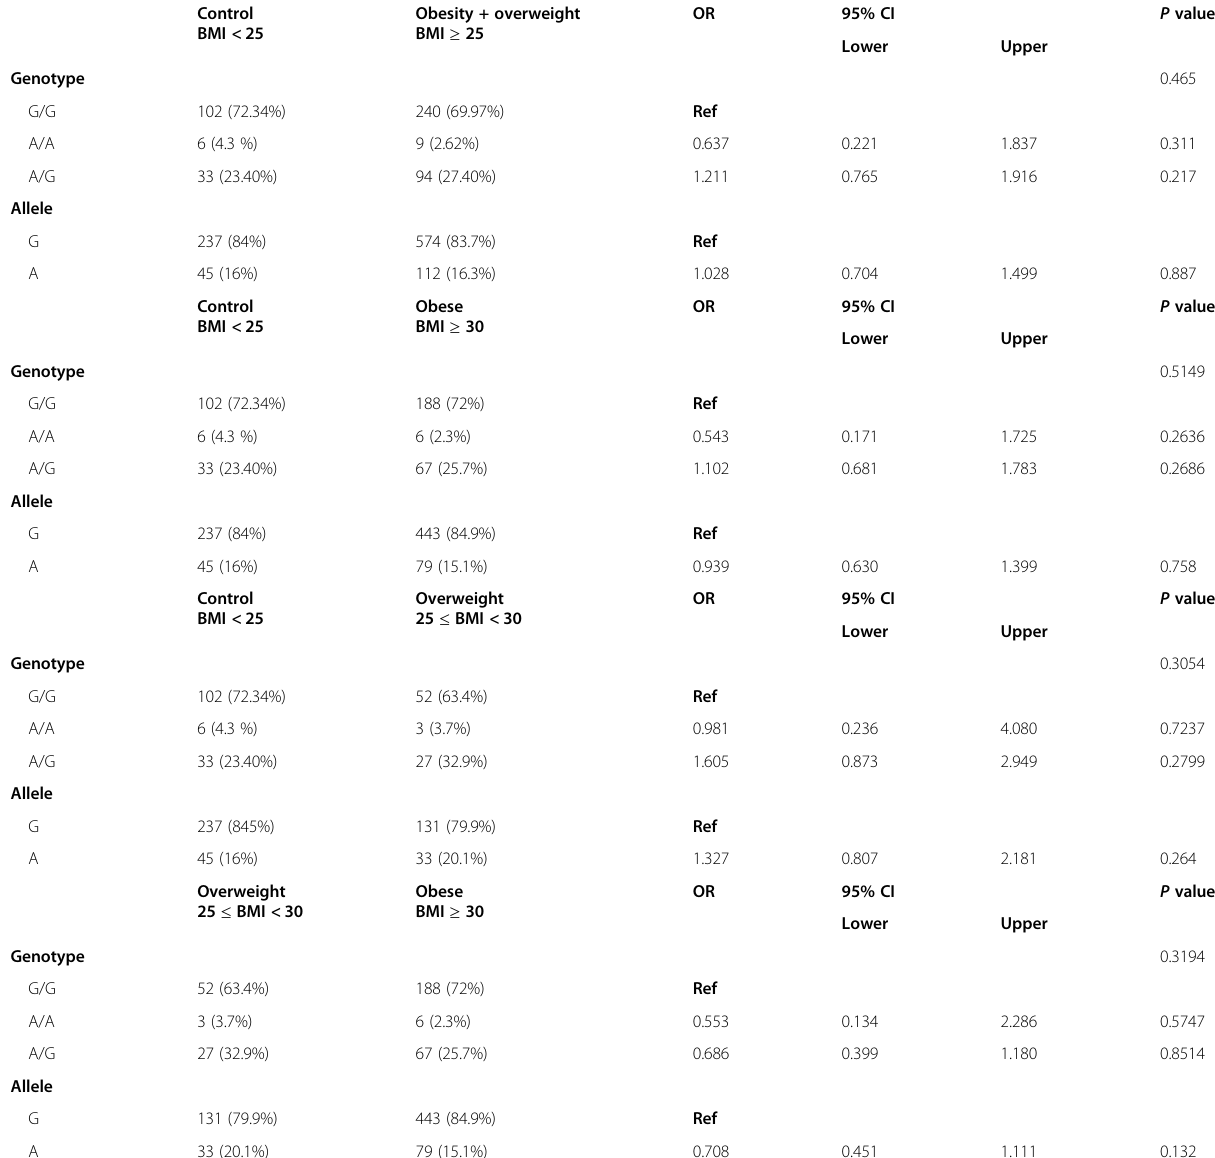
Table 2 Comparison of allele and genotype frequencies between patients (obese and/or overweight participants) and healthy